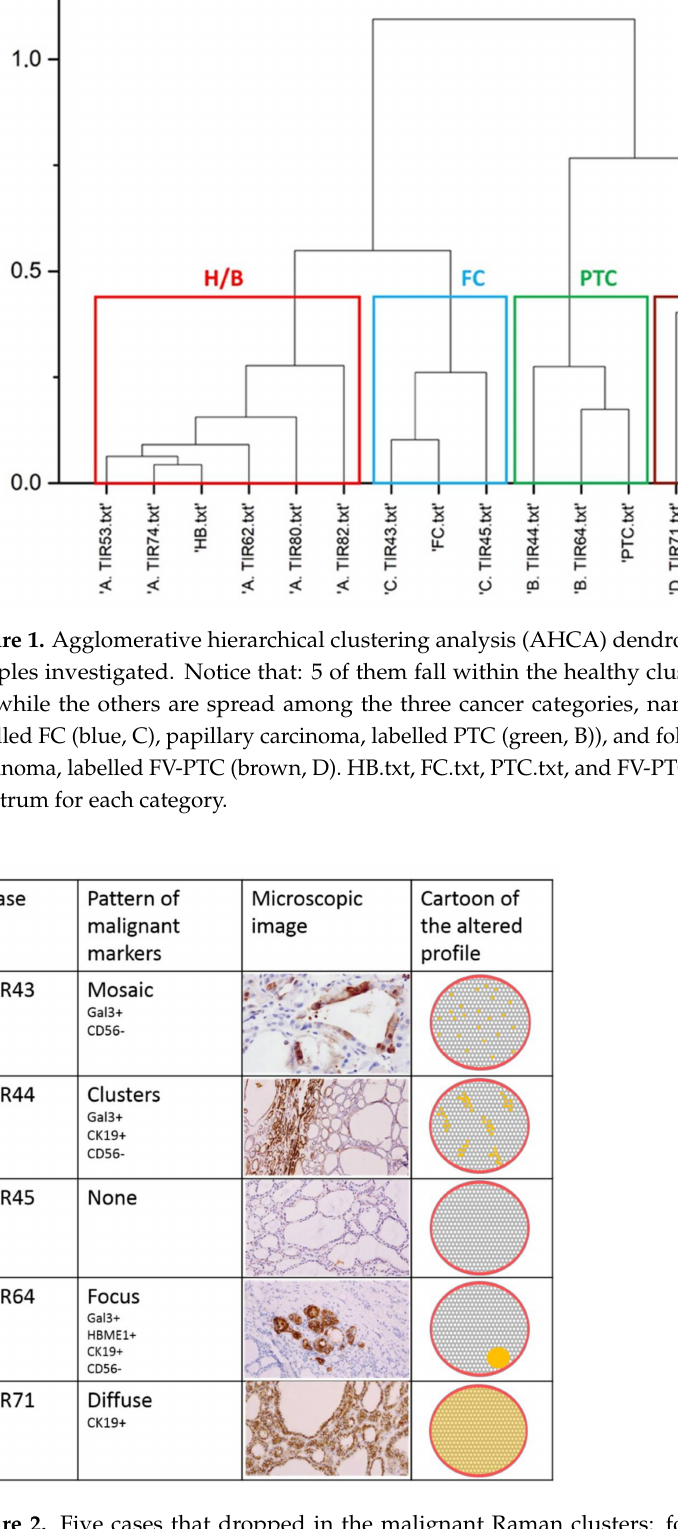
Figure 2. Five cases that dropped in the malignant Raman clusters: four of them show altered expression of immunohistochemical markers, although with different distribution on the samples. (+ positive reaction; - negative reaction)The cartoons on the right-hand panels model different patterns of markers